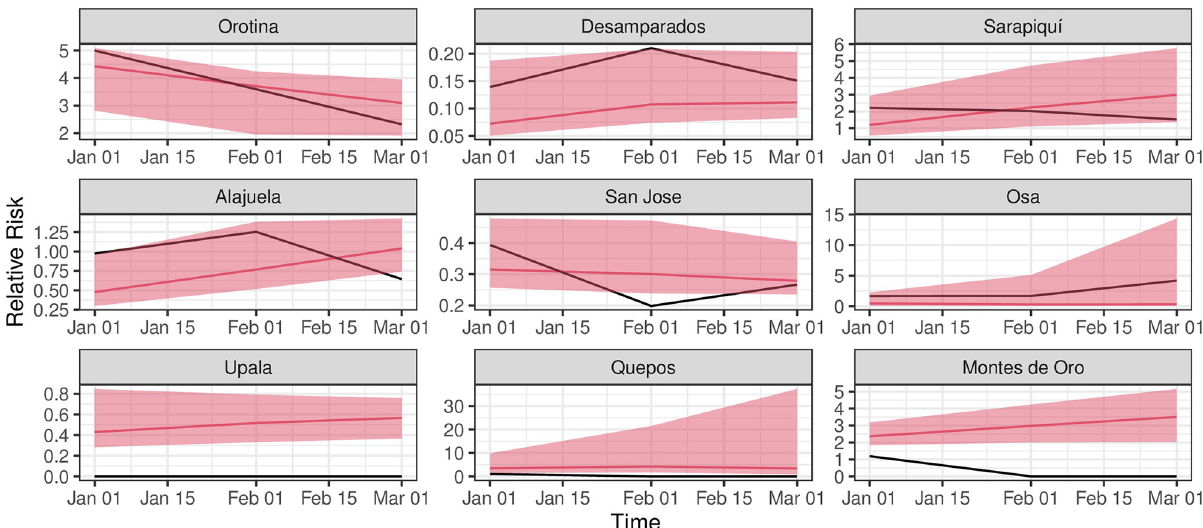
Fig 4. Forecast comparison over the testing period (2021). Upper six panels: best cantons according to NIS metric. Lower three panels: worst cantons according to NIS metric. Black line: observed RR , red line: estimated RR and red shaded area: 95%-confidence predictive region.